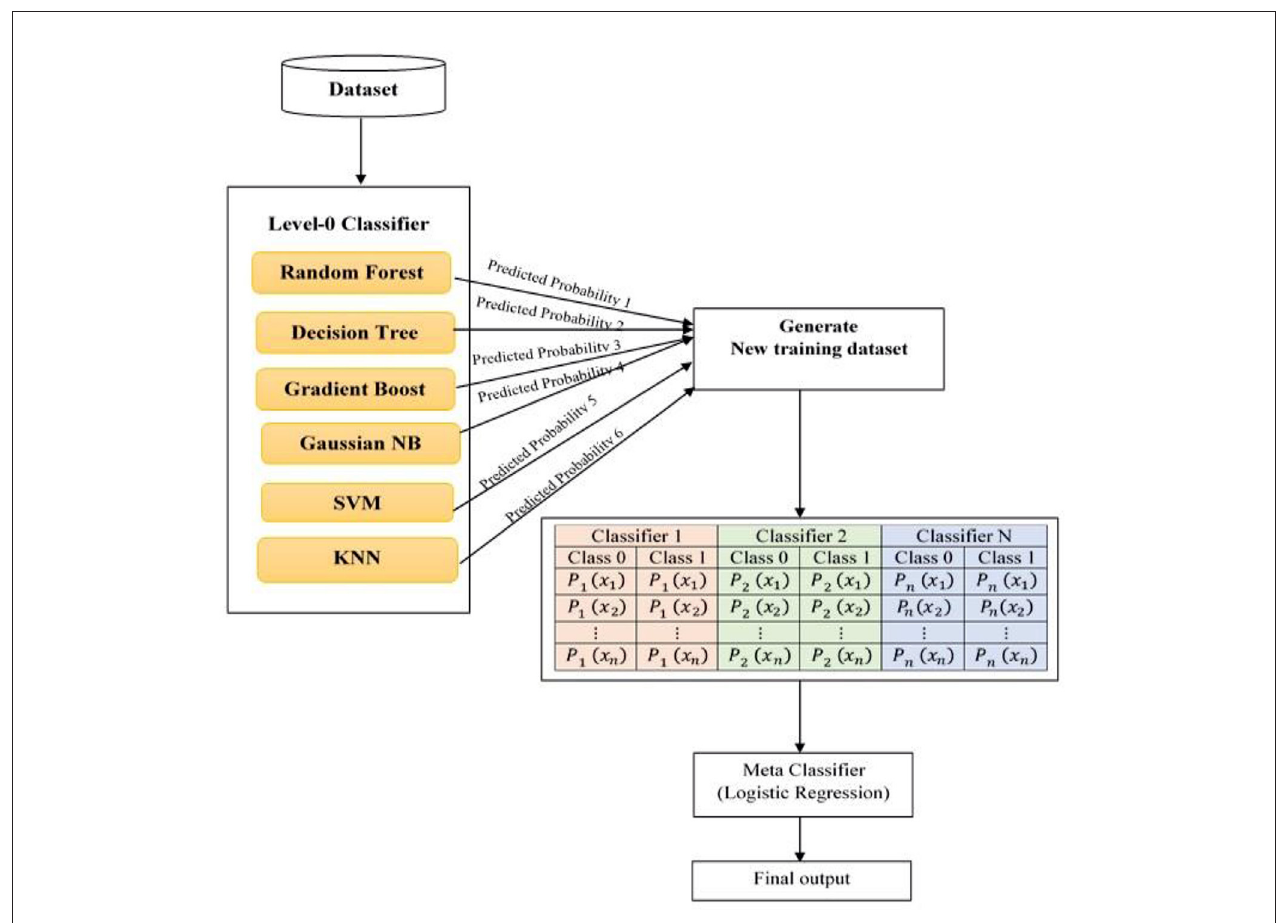
FIGURE 3 | Proposed system: Stacked ensemble model architecture.